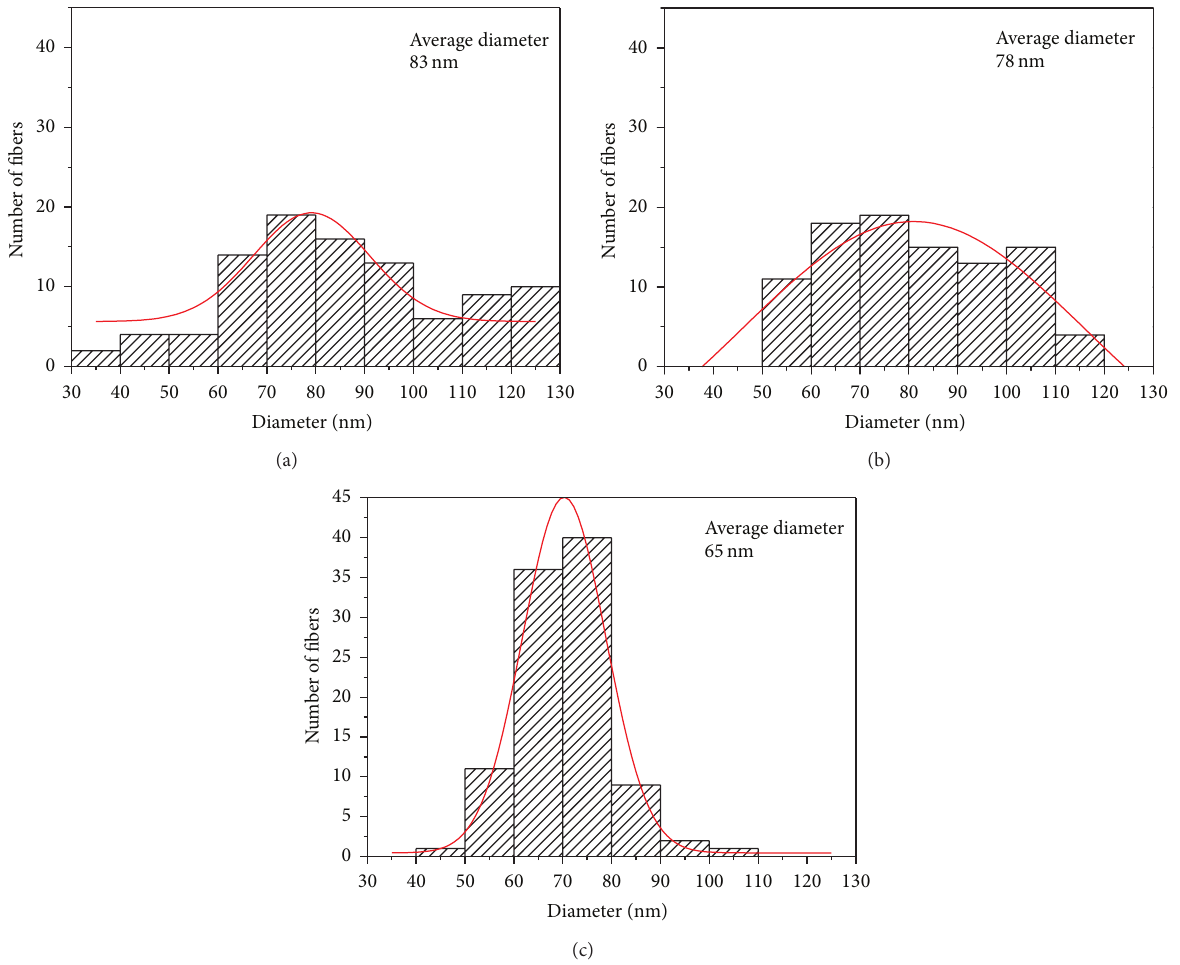
Figure 4: Diameter distribution of the blend nanofibers obtained using various weight ratios of keratin to PVA: (a) 50/50, (b) 60/40, and (c) 70/30.